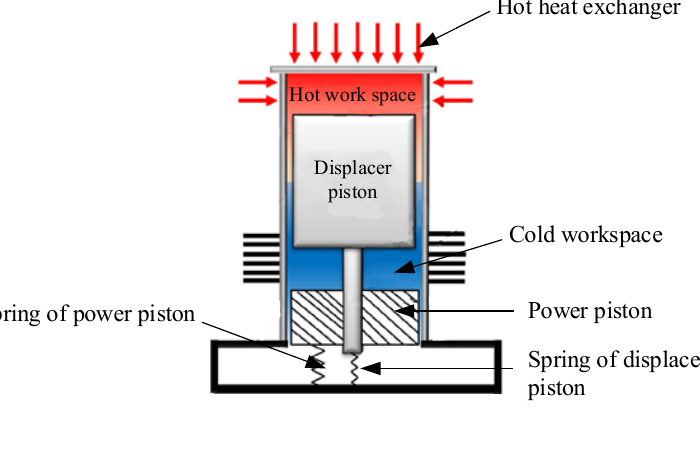
Fig. 1. Schematic of free piston Stirling engine